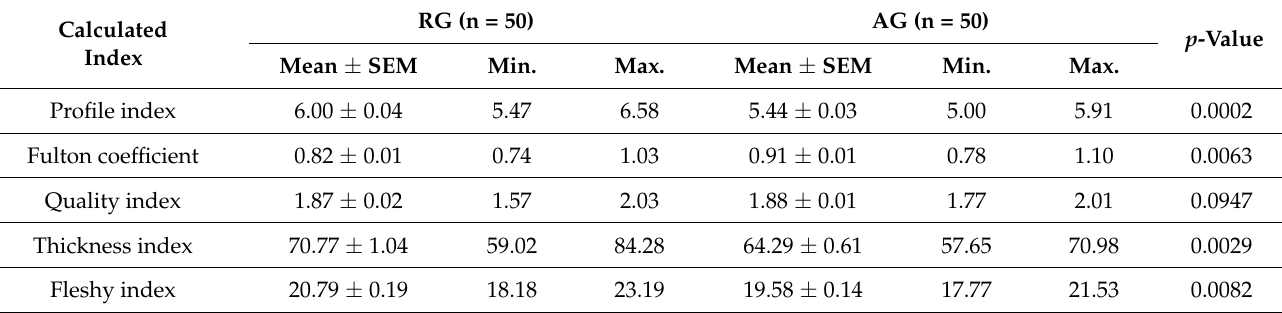
Table 2. Main body indices in Silurus glanis related to fish